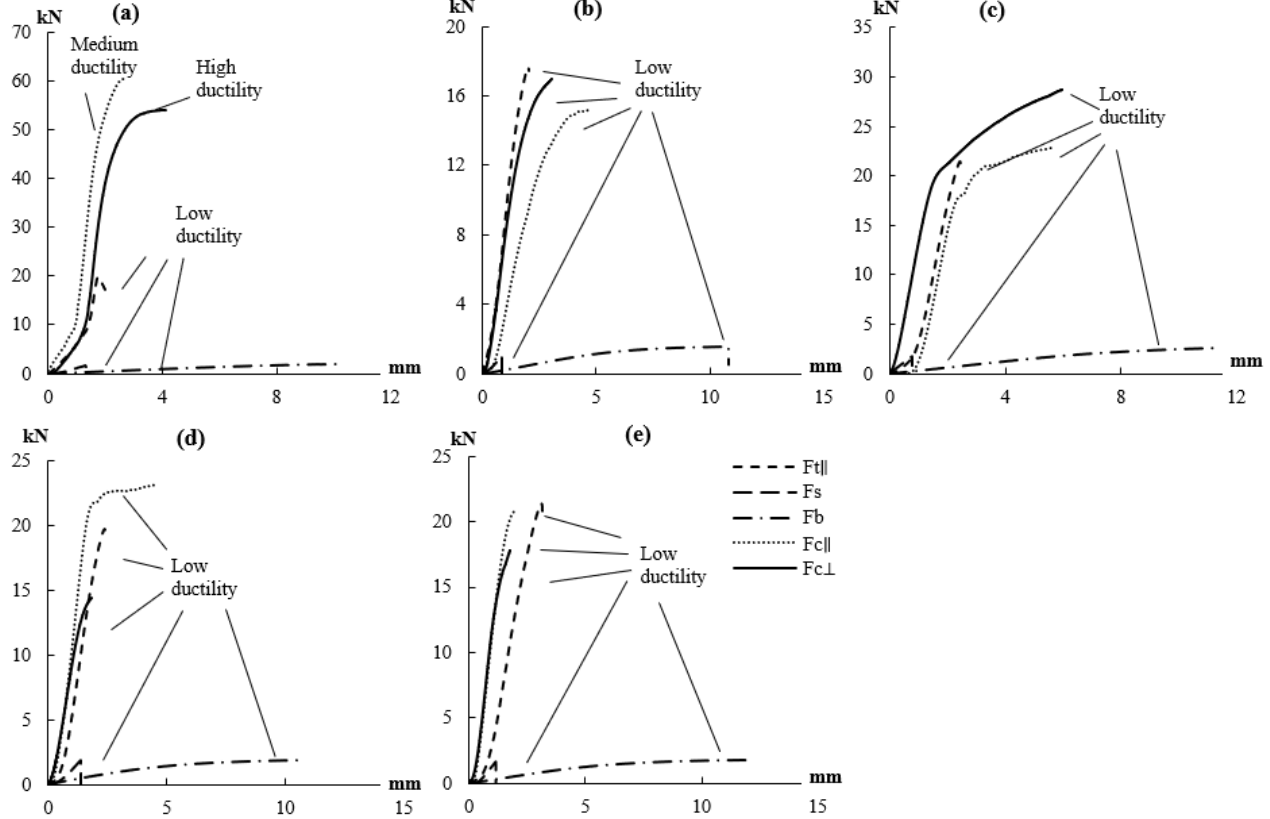
Figure 12. Load-displacement curve of mechanical properties tested in ( a ) bamboo scrimber, ( b ) agathis, ( c ) mahogany, ( d ) red meranti, and ( e ) pine.